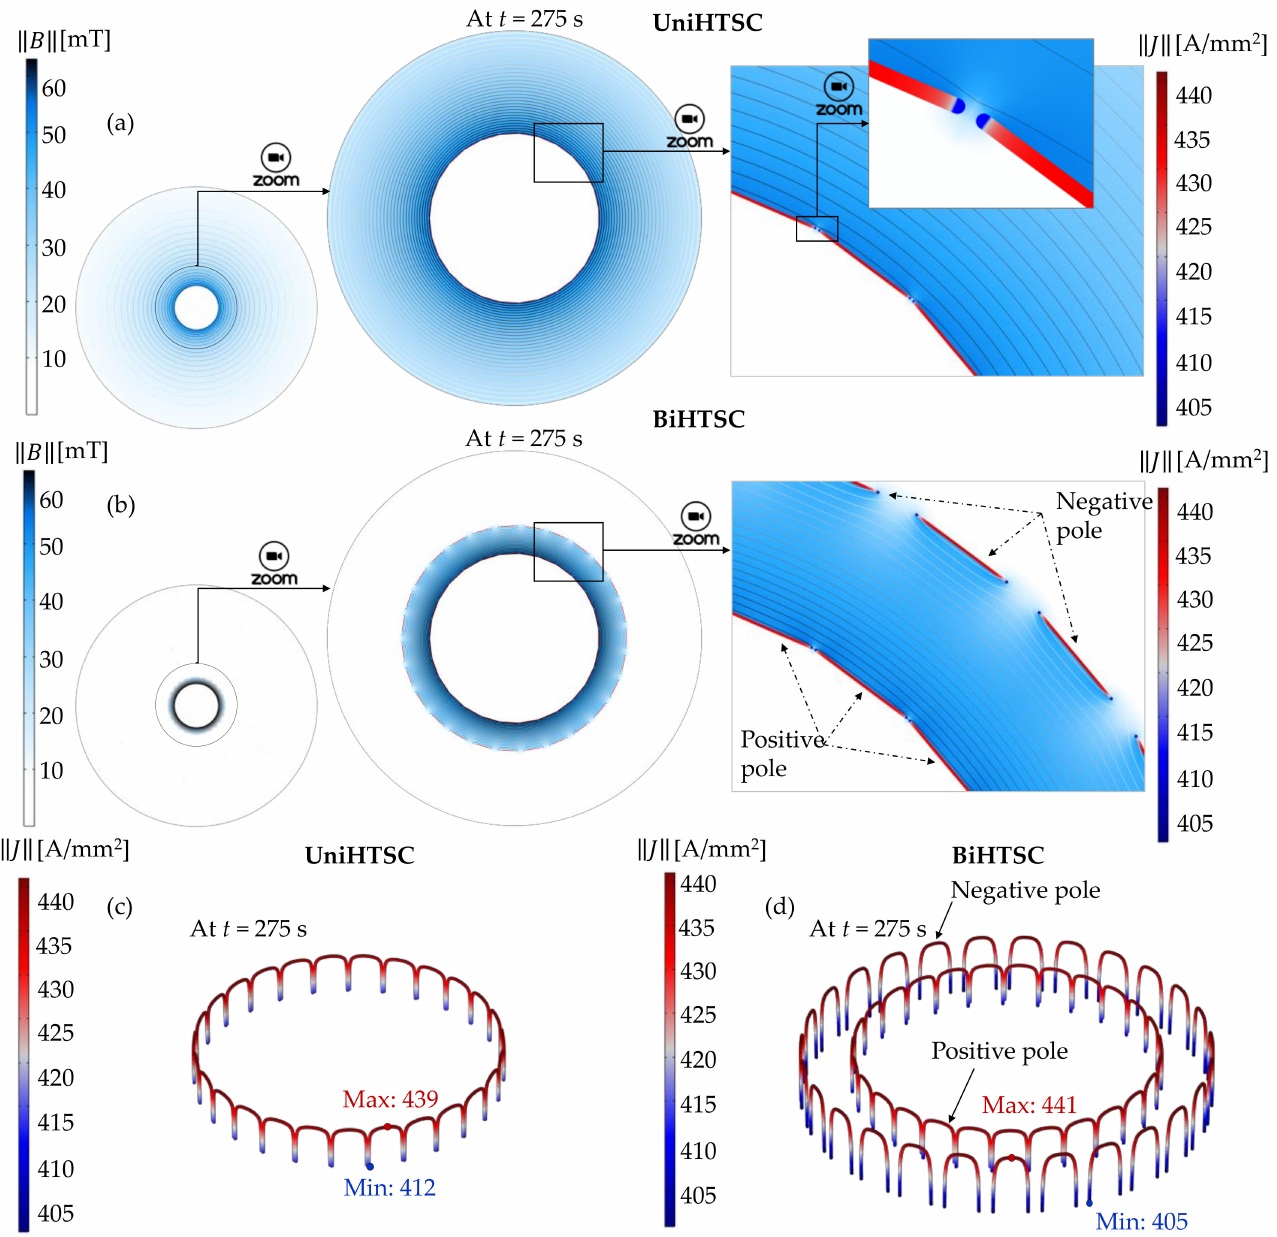
Figure 23. 2D view of the distribution of the magnetic field norm in the cable and the norm of the current density in the tapes at t = 275 s; ( a ) unipolar cable, ( b ) bipolar cable. 3D view of the distribution ( x , y , | J |) of the norm of the current density in the tapes at t = 275 s; ( c ) unipolar cable, ( d ) bipolar